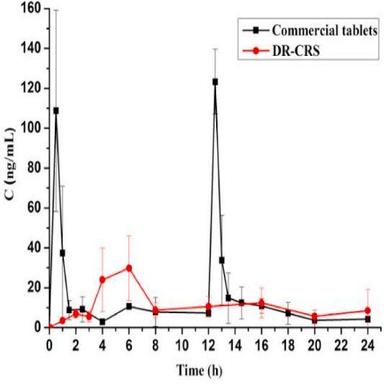
Mean plasma concentration-time curve of DR-CRS and commercial tablets in rabbits (n = 3).